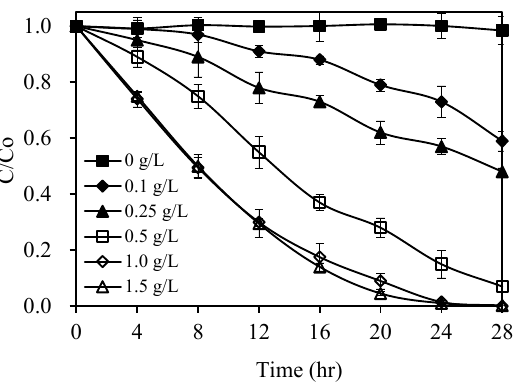
Figure 8. Effect of catalyst dosage on the photocatalytic degradation rate of pirimicarb. Experimental conditions: pirimicarb concentration 10 mg L − 1 ; pH 5. Error bars represent the standard deviations of duplicate runs.